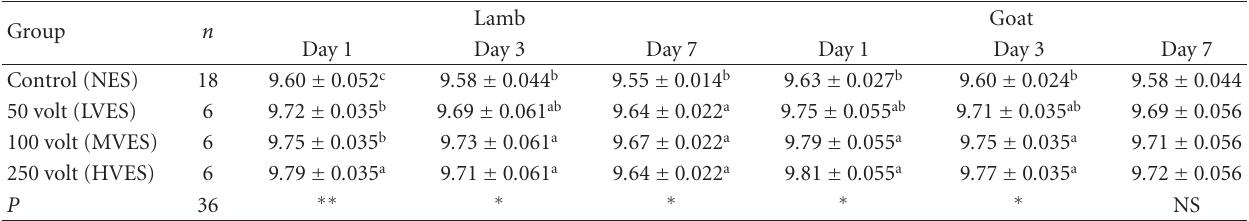
Table 2: Mean and standard errors of water activity ( a w ) values in lamb and goat meat during aging at 4 ◦ C. Lamb Group n